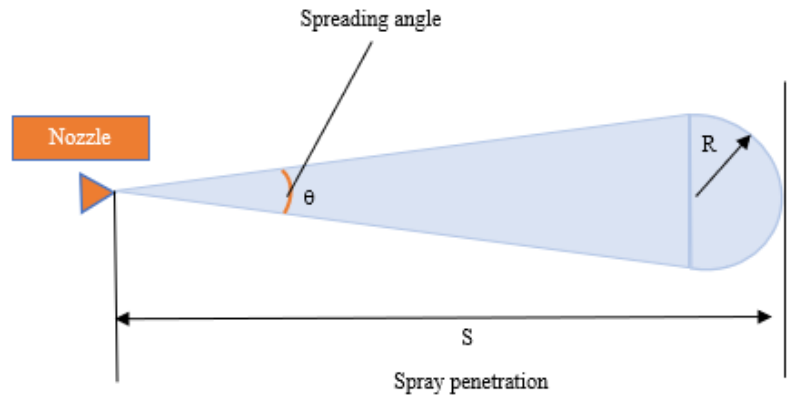
Figure 1. Delacourt’s spray schematic diagram .